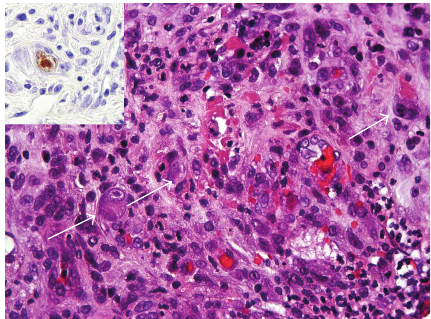
Figure 4: High-power microscopic examination (hematoxylin- eosin, x400) revealed vasculitis. Some endothelial cells present cytomegaly, suggestive of CMV infection (arrows). The presence of CMV in the jejunum was demonstrated by immunohistochemistry (inset; immunoperoxidase,